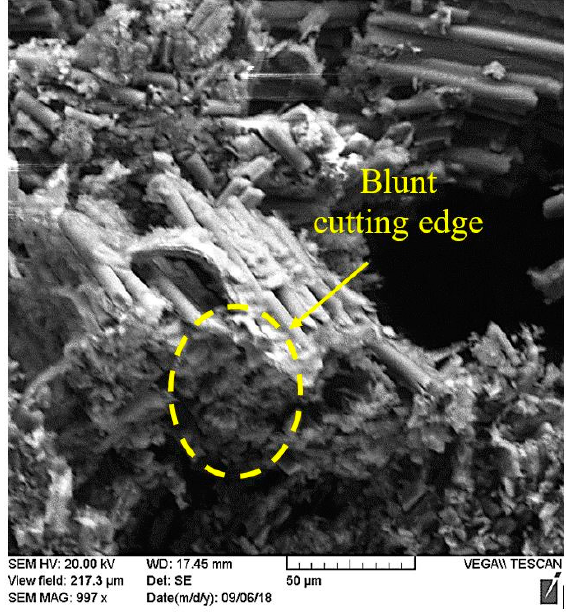
Figure 8. Effect of LF-VAD on the CFRP chips at f = 0.075 mm/rev, N = 3000 rpm, and A m = 0.48 mm.